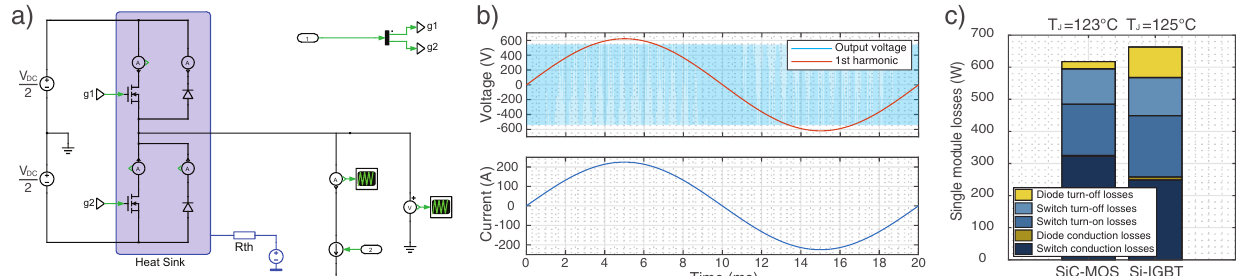
Figure 2. Selected critical operation point based on simulations and calculation of required case-to-ambient thermal resistance. ( a ) Plecs-based simulation using experimental data from characterization experiments [13]. ( b ) Critical operation point, cos( φ ) = 1 in inverter operation, M = 1.15, first harmonic of the modulated voltage is shown in phase with nominal current. ( c ) Loss distribution of a single module and junction temperature of the critical element (switch) at the critical operation